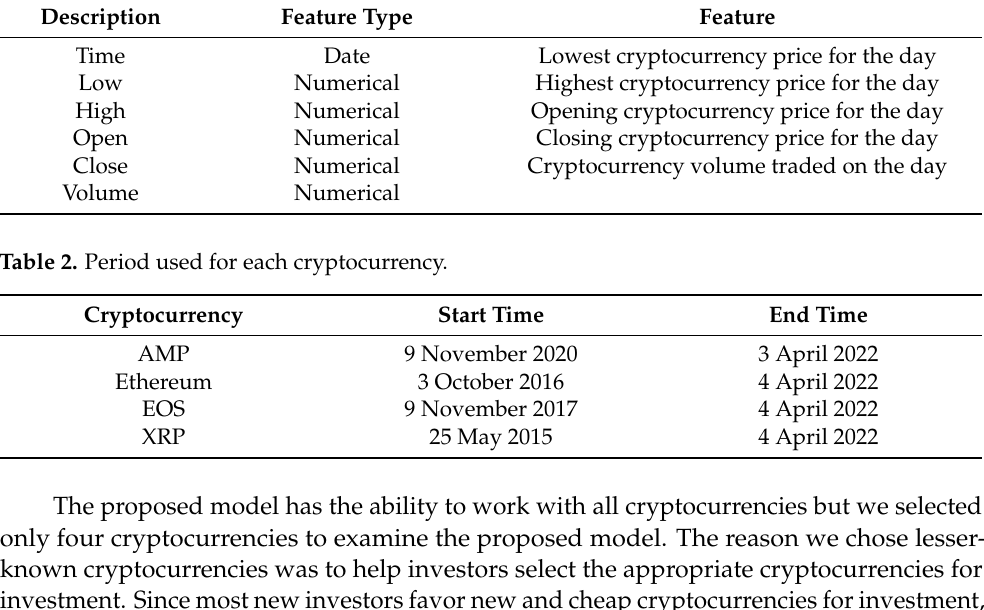
Table 1. Features of the cryptocurrencies used in this study.